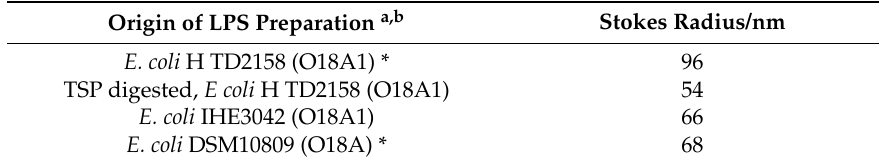
Table 1. Stokes radii of lipopolysaccharide solutions estimated from dynamic light scattering. Origin of LPS Preparation a,b